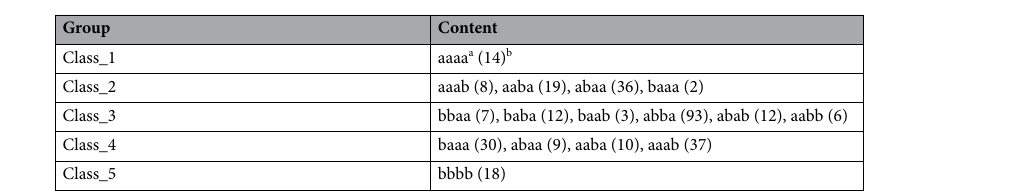
Table 1. All the 316 accessions were classified to five new group, class_1 to class_5, according to the 4 pleotropic regions. The number of hap _a in the five groups were 4, 3, 2, 1, 0. aaaa a = hapA06_a/hapA07_1_a/ hapA07_2_a/hapD11_a. b The number of the accessions belong to the aaaa was followed.